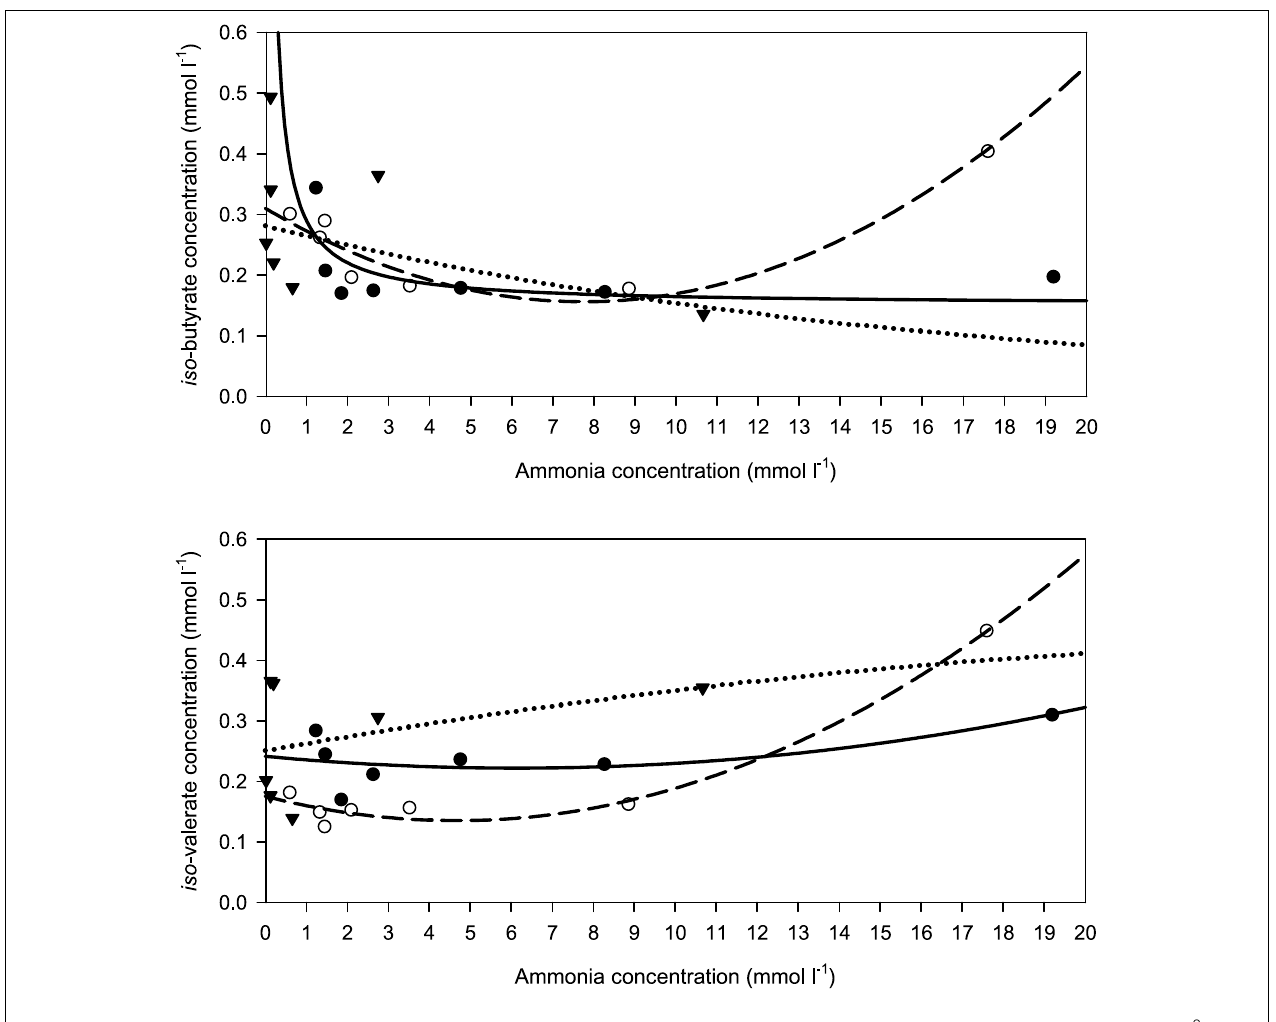
FIGURE 8 | Relationship between the concentrations of incubation fluid iso- butyrate and iso -valerate and ammonia concentration. ● brachiaria hay, for iso- butyrate: y = 0 . 151 ( ± 0.0351; P = 0 .0077) + 0.139 ( ± 0.0728; P = 0 .1144) x − 1 , R 2 = 0 . 422 , SE = 0 . 0518 , P = 0 .114, for iso- valerate: y = 0 . 242 ( ± 0.034; P = 0 .00021) − 0.00641 ( ± 0.01193; P = 0 .6213) x + 0.000520 ( ± 0.00057; P = 0 .4147) x 2 , R 2 = 0 . 460 , SE = 0 . 0414 , P = 0 .292, ▼ apple pomace, for iso- butyrate: y = 0 . 282 ( ± 0.0483; P = 0 .0021) exp[0.0602 ( ± 0.0514; P = 0 .2939) x], R 2 = 0 . 303 , SE = 0 . 206 , P = 0 .200, for iso- valerate: y = 0 . 251 ( ± 0.0551; P = 0 .0104) +